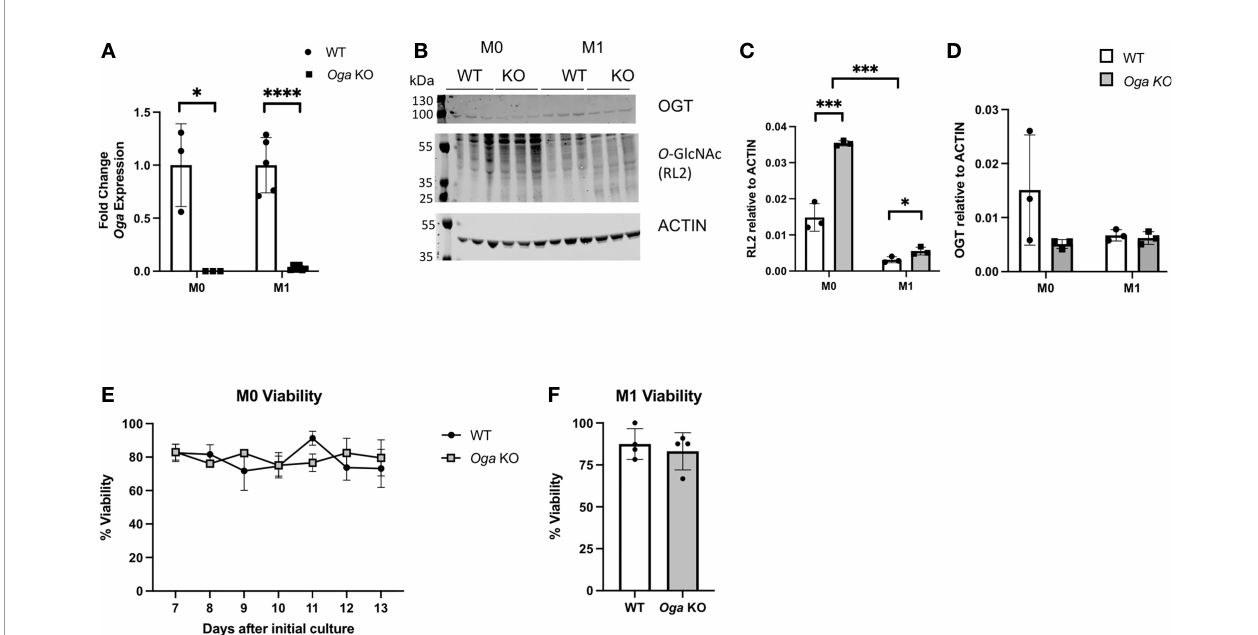
FIGURE 1 | Increased O -GlcNAcylation in BMDMs derived from Oga Vav-Cre mice. BMDMs derived from Oga Vav-Cre (KO, grey bars) or wildtype (WT, white bars) mouse bone marrow were stimulated with LPS and IFN- g (M1) for 24 hours or cultured in unsupplemented BMDM media (M0). (A) Oga gene expression was measured in M0 and M1 macrophages. Expression was normalized to the geometric mean of Rplp0 and Eef2 and represented as fold change, N = 3-5. (B – D) O -GlcNAc (using the RL2 antibody) and OGT levels were assessed in M0 and M1 macrophages, with a representative blot (B) and quantitation (C-D), N = 3. (E, F) Percent cell viability was measured using trypan blue starting 7 days after initial culture in BMDM media (E) and 1 day after M1 polarization (F) , N = 3-4. Error bars represent standard deviations. *p < 0.05, ***p < 0.005, ****p < 0.00005 as determined by student ’ s t-test, or 2-way ANOVA when comparing O- GlcNAc levels between M0 and